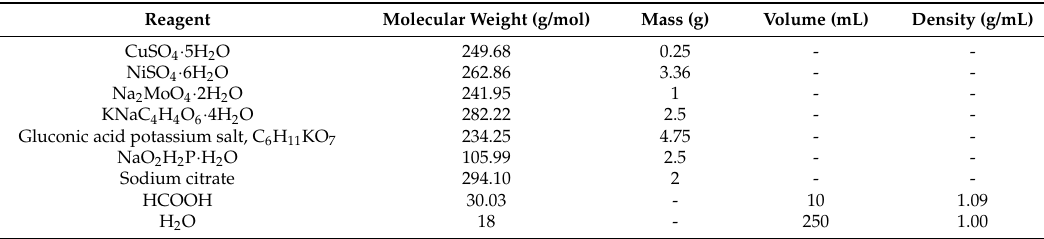
Table 1. Chemical constituents used in the production of the CuNiMoP bath.